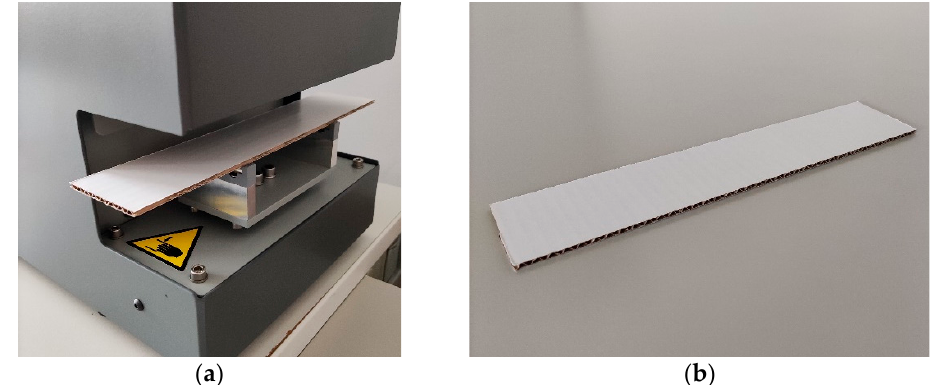
Figure 4. Bending stiffness test: ( a ) the testing socket and ( b ) the corrugated board sample.